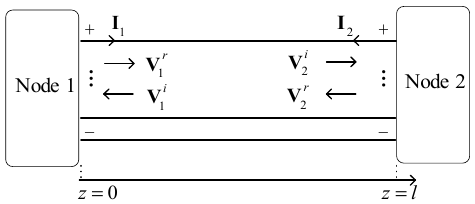
Figure 1. Model of the multiconductor transmission line network with two nodes.